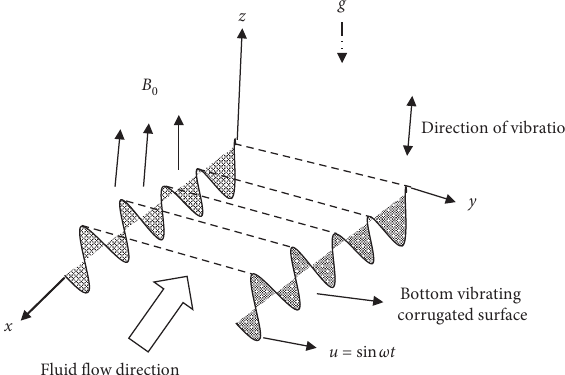
Figure 1: Schematic diagram with